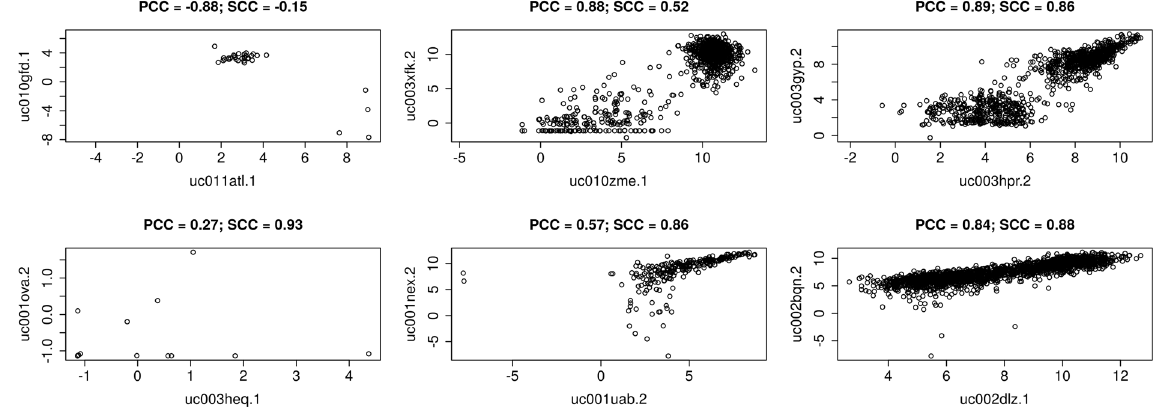
Figure 1. High, Medium, and Low Differences in Gene Expression Dependency. These scatterplots provide examples of high, medium and low differences in correlation between the Spearman and Pearson correlation methods. The x and y-axes represent log2 transformed gene expression levels for each gene respectively. The two plots on the left (top and bottom) represent pairwise correlation between transcripts with high differences between correlation where either Pearson correlation coefficient (PCC) is high and Spearman correlation coefficient (SCC) is low or vice versa. There are fewer samples when compared to other plots because of missing values. The middle two plots represent high correlation in one method and mid-range in the other. The right two plots are examples where both PCC and SCC are high. The title of each scatterplot indicates the PCC and SCC values for each